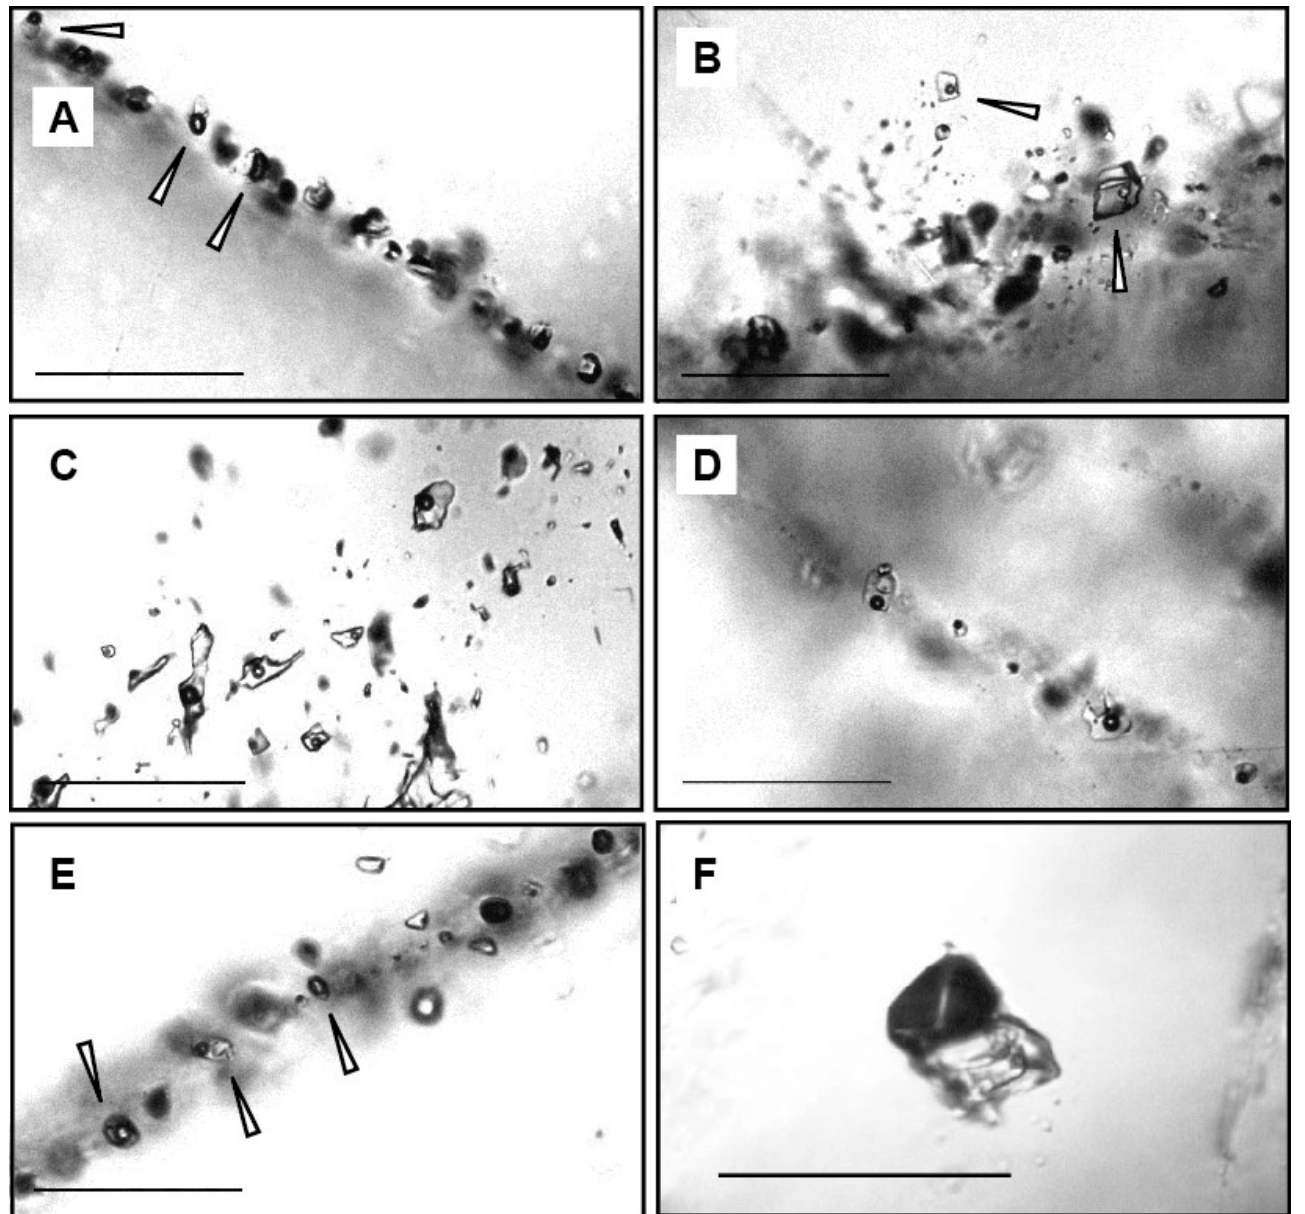
Figure 3. Photomicrographs of fluid and melt inclusions in the Eonyang UST sample. Scale bars represent 50 µm. ( A ) A pseudo-secondary assemblage of melt-fluid inclusions in the UST quartz. The arrows show inclusions of mixed silicate melt and aqueous fluid. ( B ) A pseudo-secondary assemblage of silicate melt inclusions and aqueous fluid (liquid-rich) inclusions in the UST quartz. The melt and fluids (arrowed) are possibly trapped co-genetically. ( C ) A pseudo-secondary assemblage of aqueous liquid-rich inclusions in the UST quartz. ( D ) A pseudo-secondary assemblage of hypersaline (brine) inclusions in the UST quartz. ( E ) A pseudo-secondary assemblage of co-trapped brine and vapor-rich inclusions (boiling assemblage) in the UST quartz. ( F ) A silicate melt inclusion in a quartz phenocryst. The melt inclusion is internally crystallized.